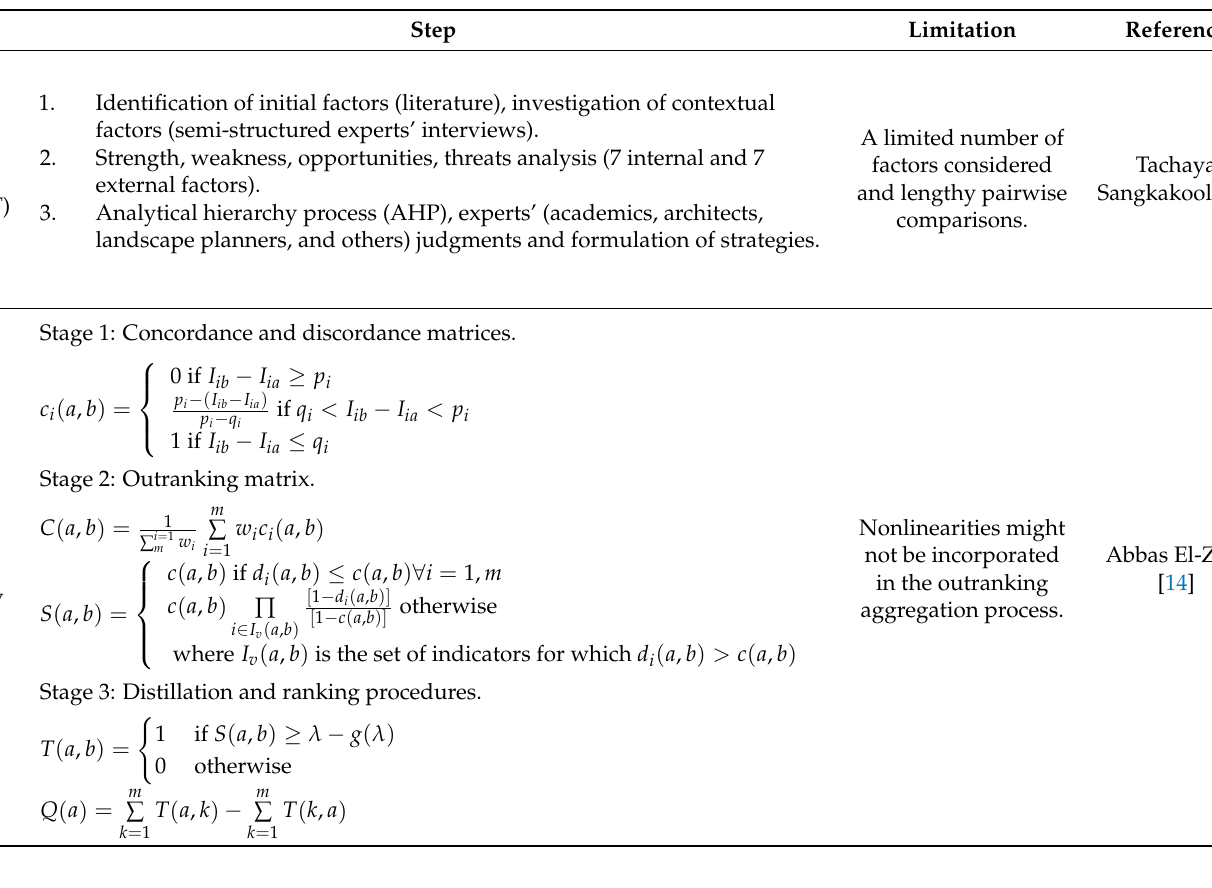
Table 1. Review of academic research on multi-criteria DST approaches for urban heat